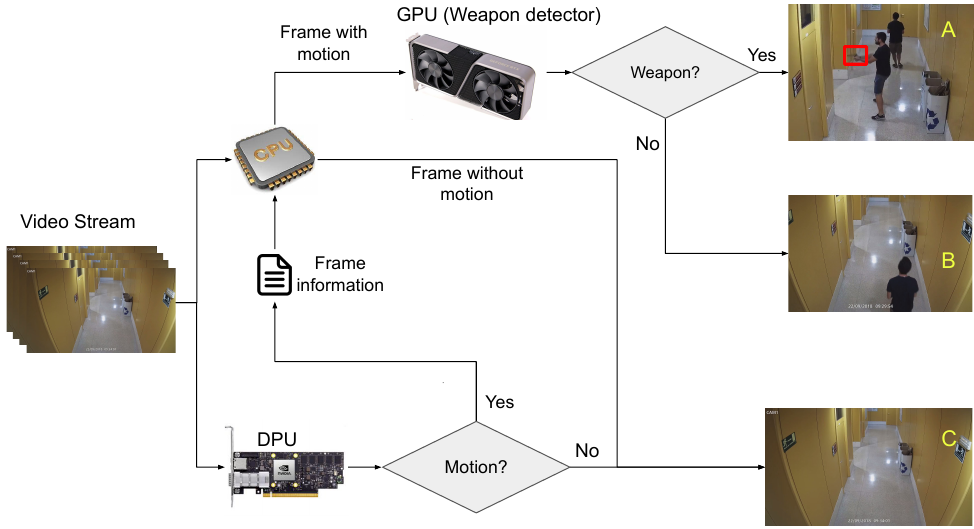
Figure 3. Video stream processing flow. Both the DPU and the CPU read the video stream. GPU applies fine processing only when motion is detected. Frames belong to the public dataset from Salazar et al.